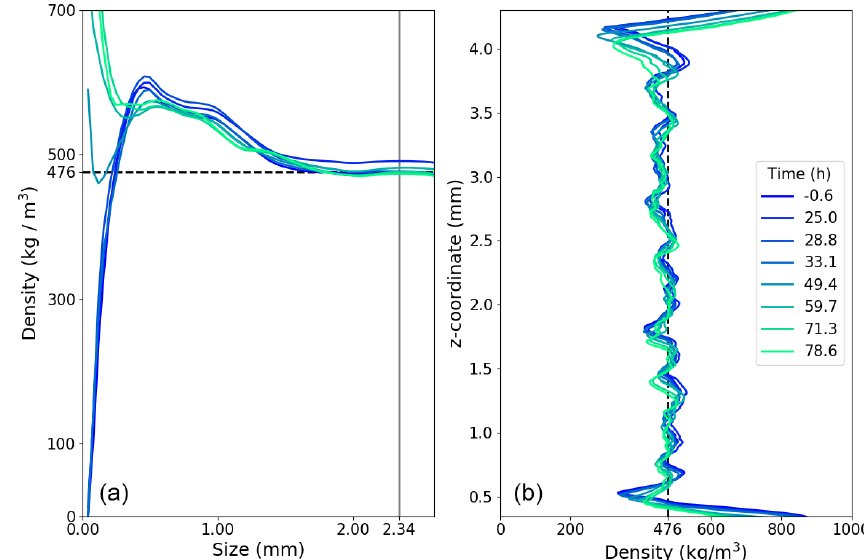
Figure 8. Density measurements. (a) Representative elementary volume estimation for density, computed from centred cubic subvolumes of variable sizes. (b) Vertical variation of density computed on centred discs of one-voxel height and 3.3mm in diameter.